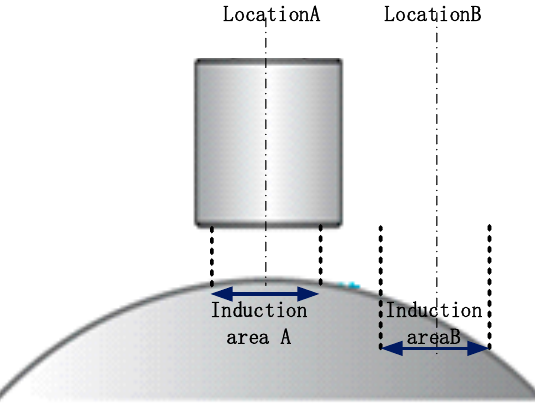
Figure 8. Nonlinear analysis of capacitive displacement sensor.